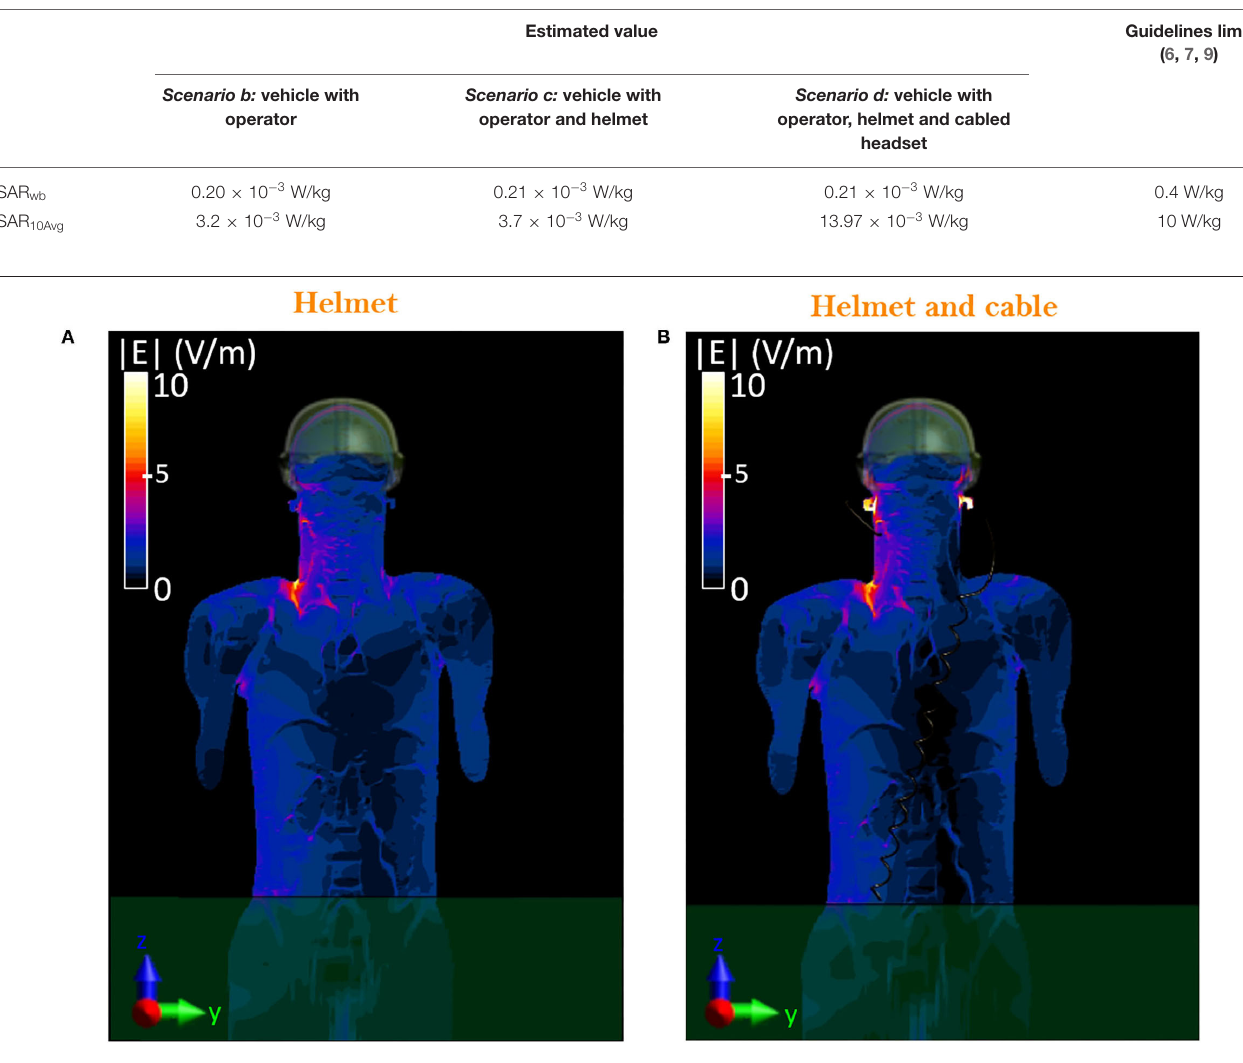
FIGURE 7 | Distribution of the E-field induced inside the head of the virtual body model: comparison on the frontal plane, YZ, between equipped military operator wearing the sole helmet (A) and the helmet with the cabled headset (B)